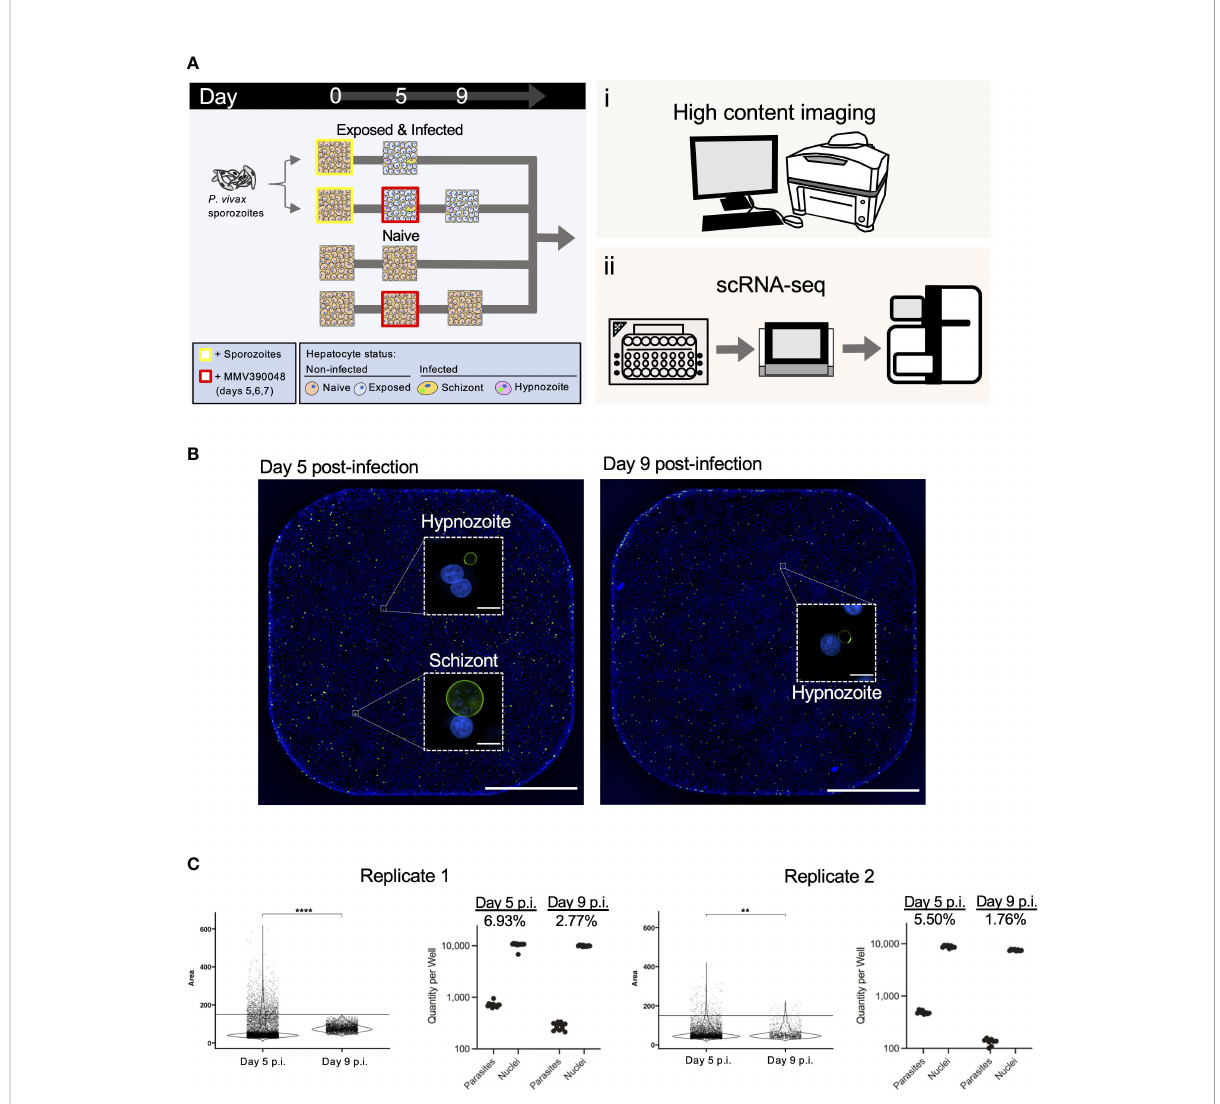
FIGURE 1 Design and validation of detection of P. vivax liver stages using high-content imaging and scRNA-seq. (A) Schematic illustrating the sample preparation and data generation pipeline used to assess P. vivax liver stage infection rates and gene expression. (B) Representative high content images of primary hepatocytes infected with P. vivax on day 5 (left) and day 9 (right) post-infection (p.i). Images were captured from one well from a 384-well plate with a 4x objective. Inset: one fi eld of view (white dashed box) from the same well captured with a 20x objective. Cells were stained with DAPI (blue) and PvUIS4 (green). White bar represents 1mm, inset bars represent 10µm. Images are representative of replicate 1. (C) Violin plots displaying the distribution of parasite growth areas fi xed at day 5 or day 9 post-infection (left) and net quantity of parasites and hepatocyte nuclei (right). Net infection rate is indicated for each endpoint. Growth and infection metrics are shown for both replicates. ****, p < 1.00E-04; **, 1.00E-03; Wilcoxon